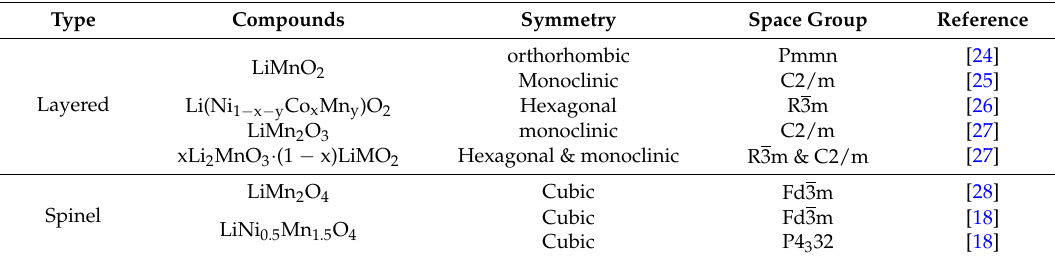
Table 3. Several crystal structures of Mn-based